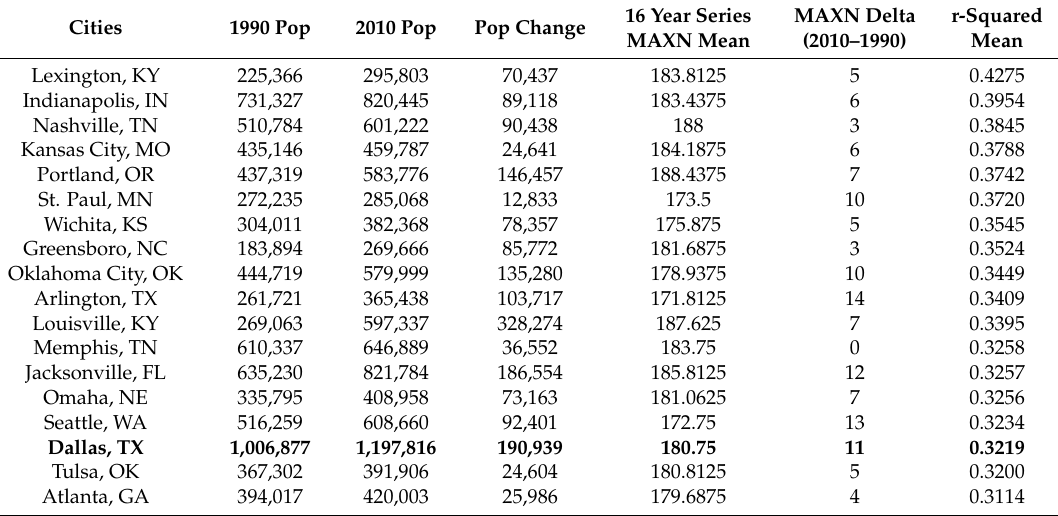
Table 3. Regression relations of time series 16 year MAXN, MAXN Delta (regression coefficient for the time variable showing trend in NDVI), and descriptive statistics of r-squared for 58 Growing Cities. We selected two cities Dallas and Tucson that were one standard deviation above the overall r-squared mean and one standard deviation below the overall r-squared mean, to show cities that were different from the typical cities. The cities had a low, typical, and high, 16-year series r-squared